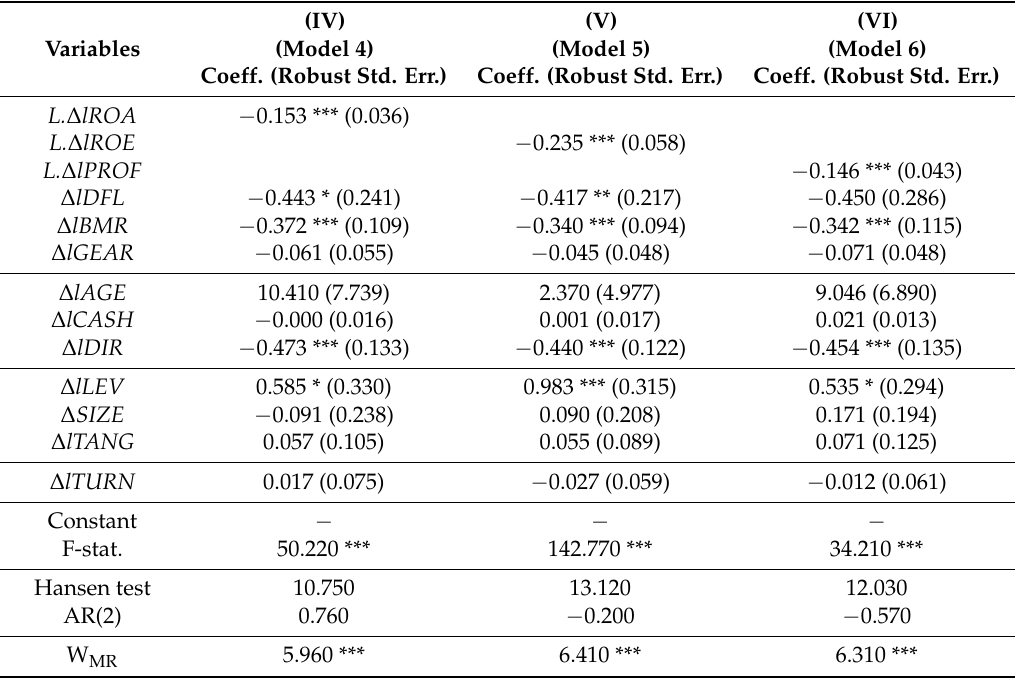
Table 7. Results of the difference-generalized method of moments